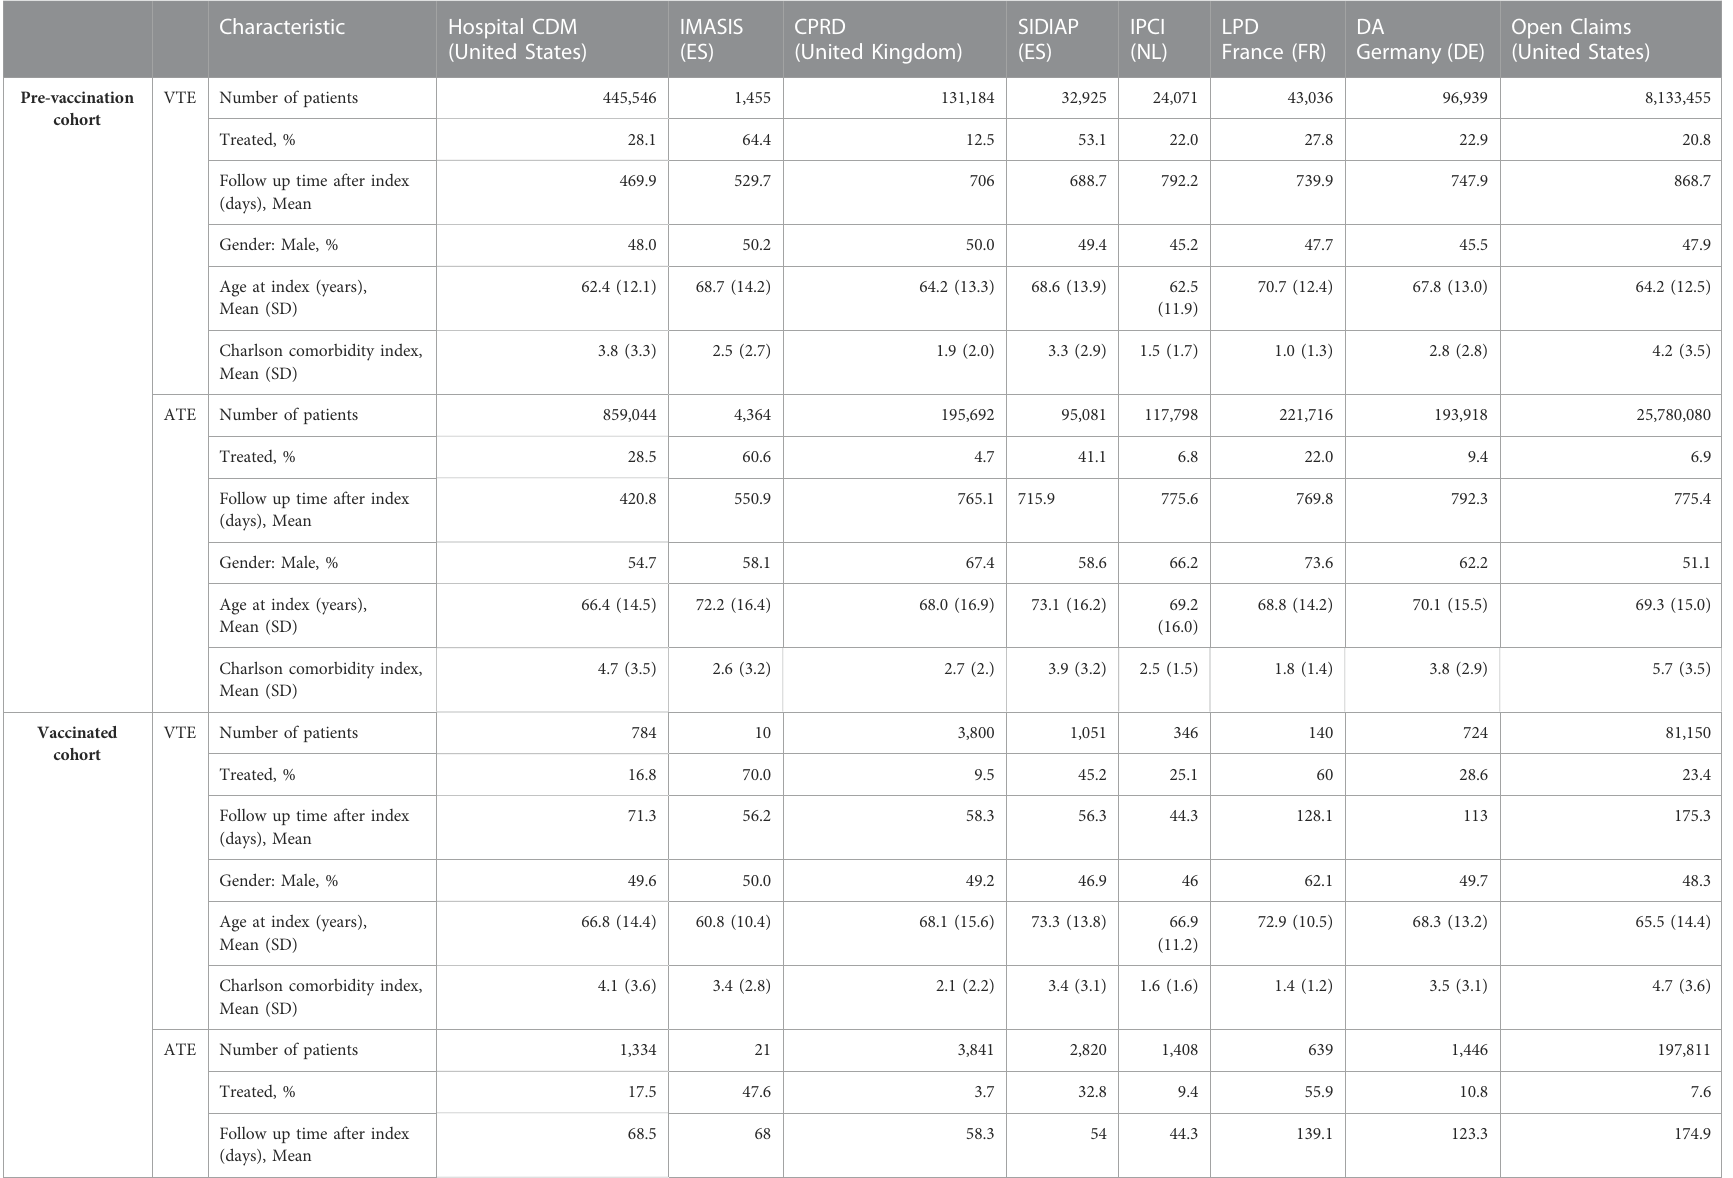
TABLE 4 Baseline characteristics of pre-vaccination versus vaccinated VTE and ATE patients.